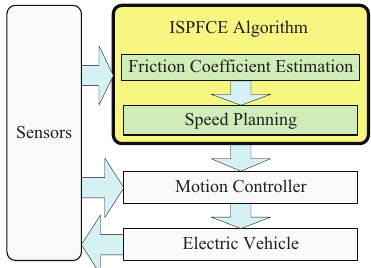
Figure 1. Structure of a vehicle system including the proposed algorithm.